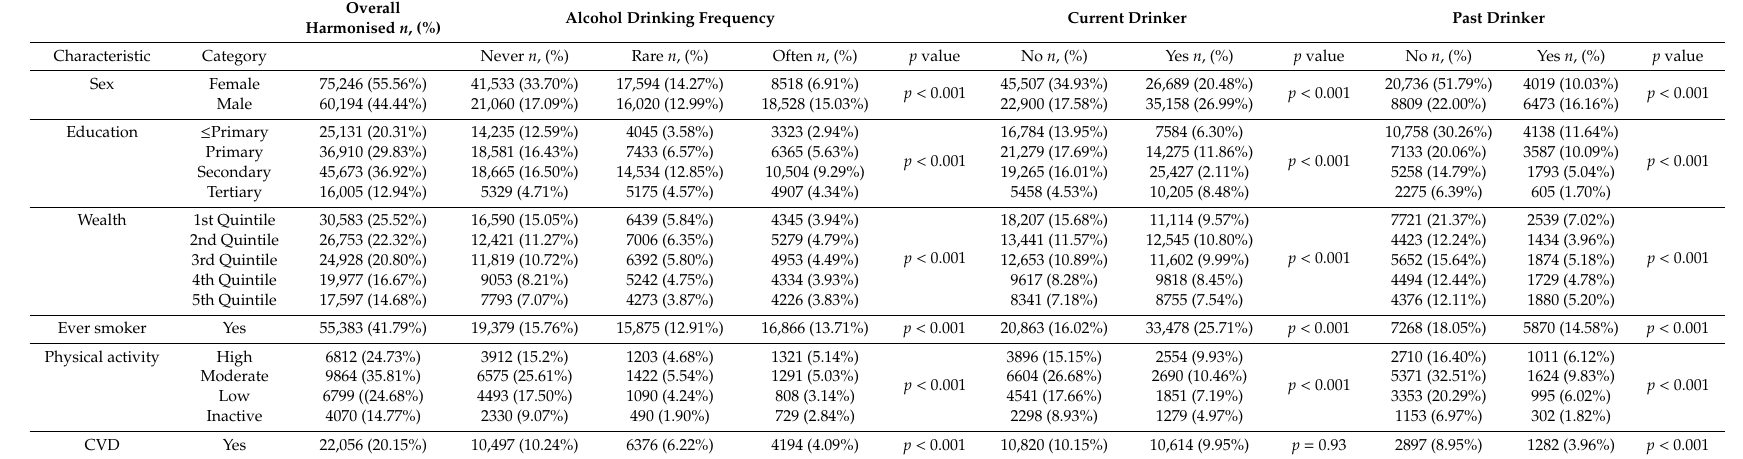
Table 1. Baseline characteristics of the study—overall harmonised sample by alcohol drinking.